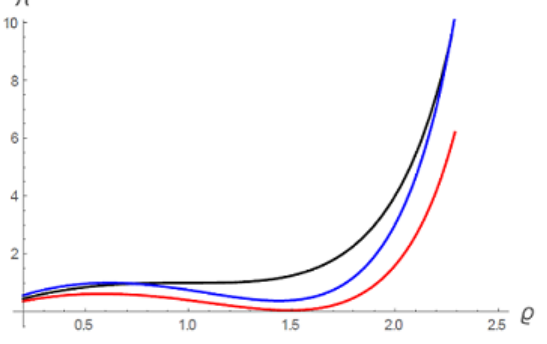
Figure 2. Isotherms for a MacMillan-Mayer Van der Waals solution (Equation (2)). β = 1 for all isotherms. Black: t = 1, hence α = 1. Blue: α = t 1.5 , t = 1.3. Red: α = 1, t =